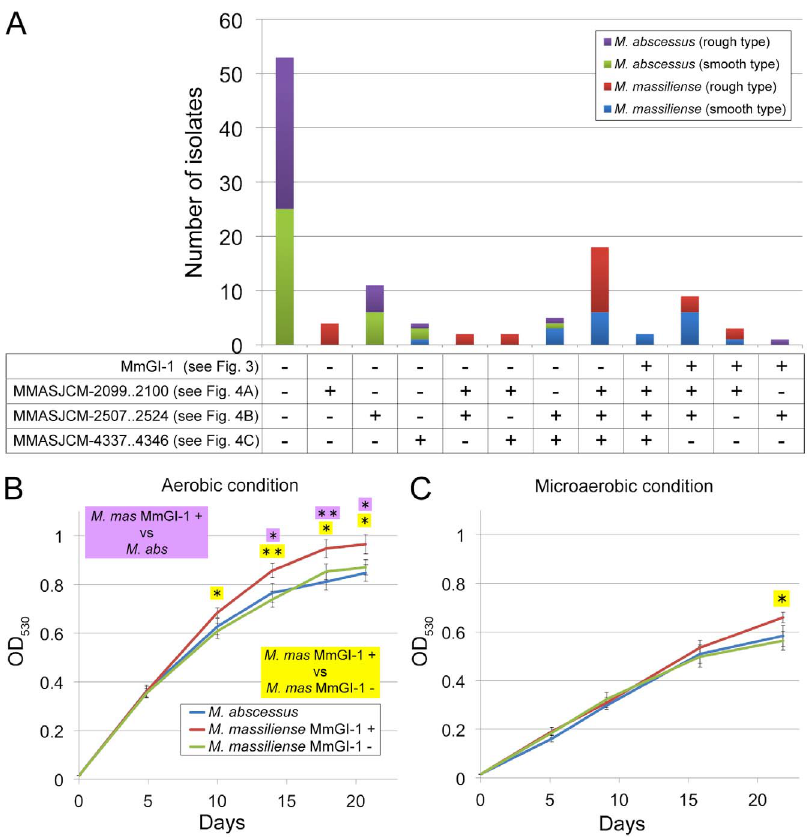
Fig. 5. Prevalence of massiliense cluster unique regions and growth curve analysis in Japanese M. massiliense and M. abscessus isolates. A bar chart showing the prevalence of MmGI-1 and three massiliense cluster unique regions in Japanese M. massiliense and M. abscessus isolates (A). The curves represent in vitro growth (OD at 530 nm) over a period of 21 days at 37 ˚ C in aerobic (B) and microaerobic (C) conditions. Data represent the means ¡ SE from 6 MmGI-1 positive M. massiliense , 8 MmGI-1 negative M. massiliense and 12 M. abscessus isolates. M. mas and M. abs shows M. massiliense and M. abscessus , respectively. Key: + , positive; -, negative. * P , 0.05; ** P , 0.01 (Student’s